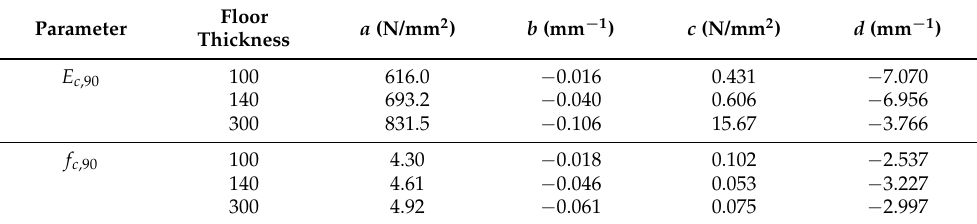
Table 7. Coefficients of regression curves shown in Figure 12a,b according to Equation (8) for E c ,90 , f c ,90 as a function of wall thickness, t w .